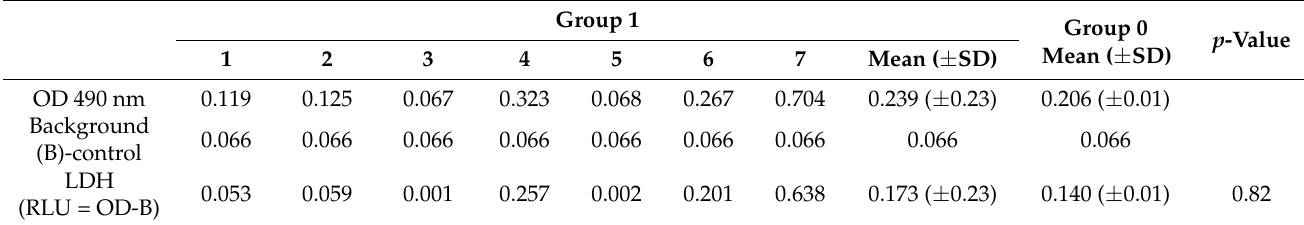
Table 3. Lactate dehydrogenase (LDH) expressed in relative luminescence units (RLU) for patients included in Group 1 compared to the mean values of the reference group (Group 0).